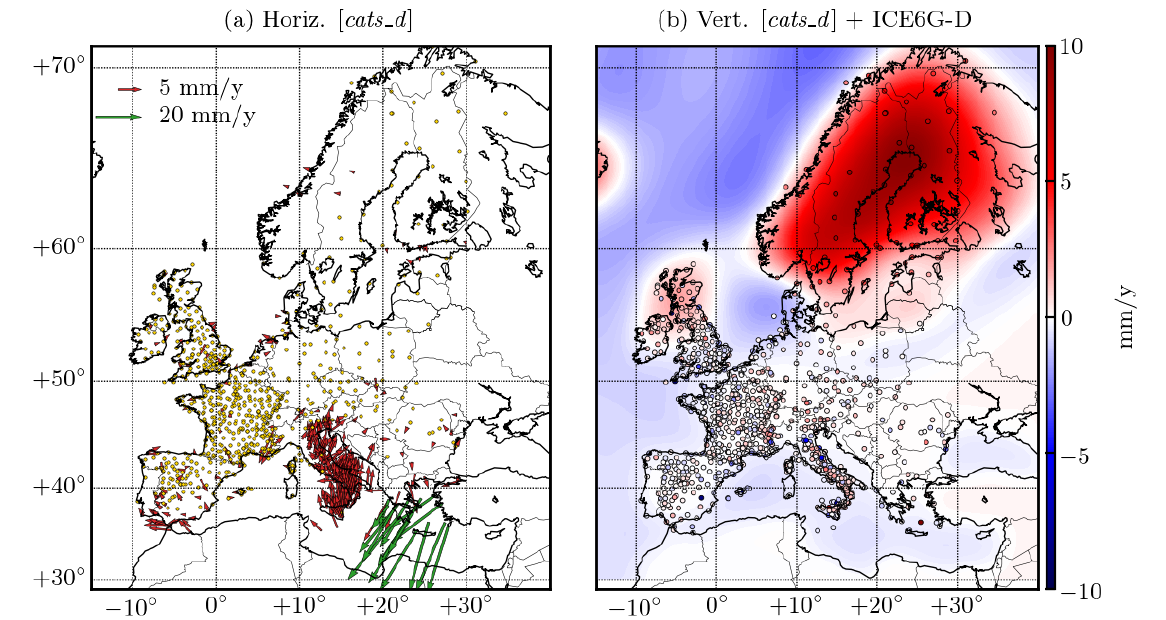
Figure 4. Velocity field of cats_d in ( a ) horizontal and ( b ) vertical direction, along with ICE-6G_D GIA model of [68]. The yellow dots in ( a ) are stations for which the horizontal velocity is lower than